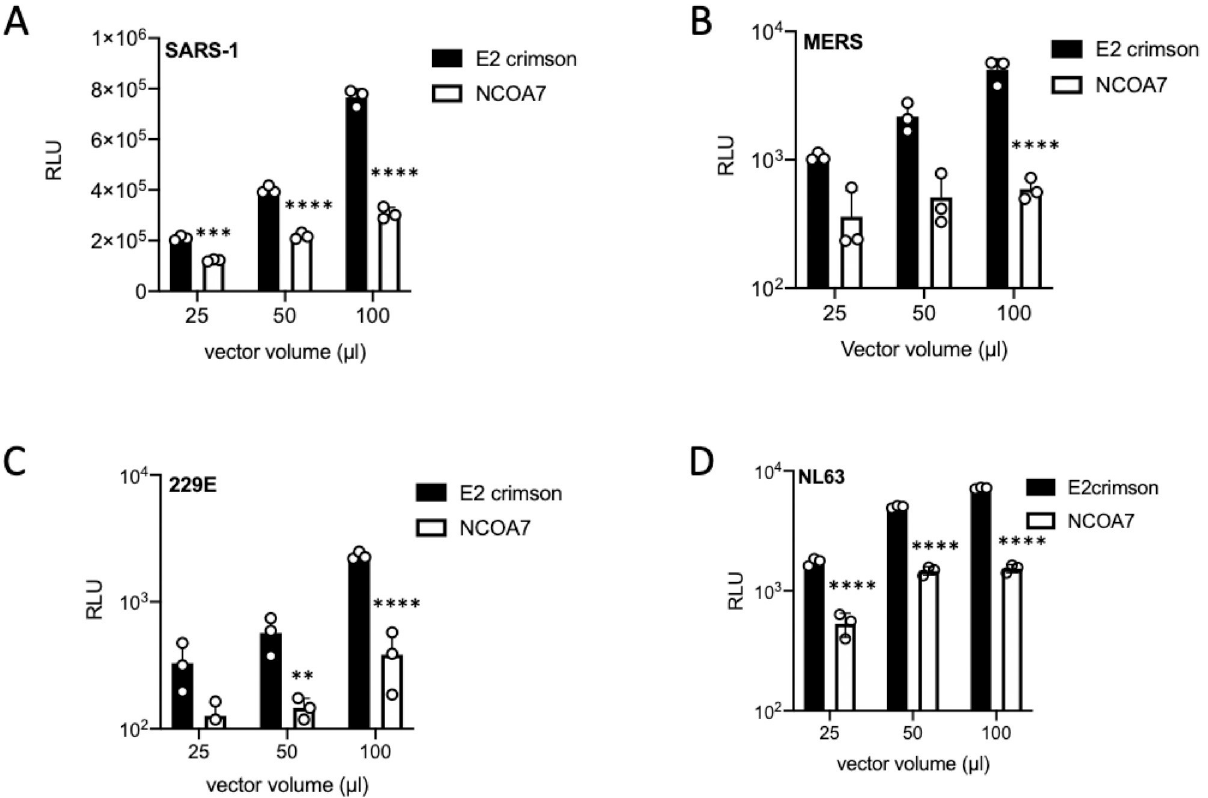
Fig 2. NCOA7 inhibits pathogenic and seasonal coronavirus infections. (A) A549-ACE2 cells expressing E2crimson or NCOA7 were infected with SARS-CoV-1 Spike pseudotyped vector expressing luciferase (SARS-1). Luciferase activity was measured 48 h post-infection. (B) U87-MG cells expressing E2crimson or NCOA7 were infected with MERS-CoV Spike pseudotyped vector expressing luciferase (MERS). Luciferase activity was measured 48 h post-infection. (C) A549-ACE2 cells expressing E2crimson or NCOA7 were infected with HCoV-229E Spike pseudotyped vector expressing luciferase (229E). Luciferase activity was measured 48 h post-infection. (D) U87-MG-ACE2 cells expressing E2crimson or NCOA7 were infected with HCoV-NL63 Spike pseudotyped vector expressing luciferase (NL63). Luciferase activity was measured 48 h post-infection. For all the data n = 3, mean +/- SD. All analysed using two-way ANOVA � (p < 0.05), �� (p < 0.01), ��� (p < 0.001), ���� (p <